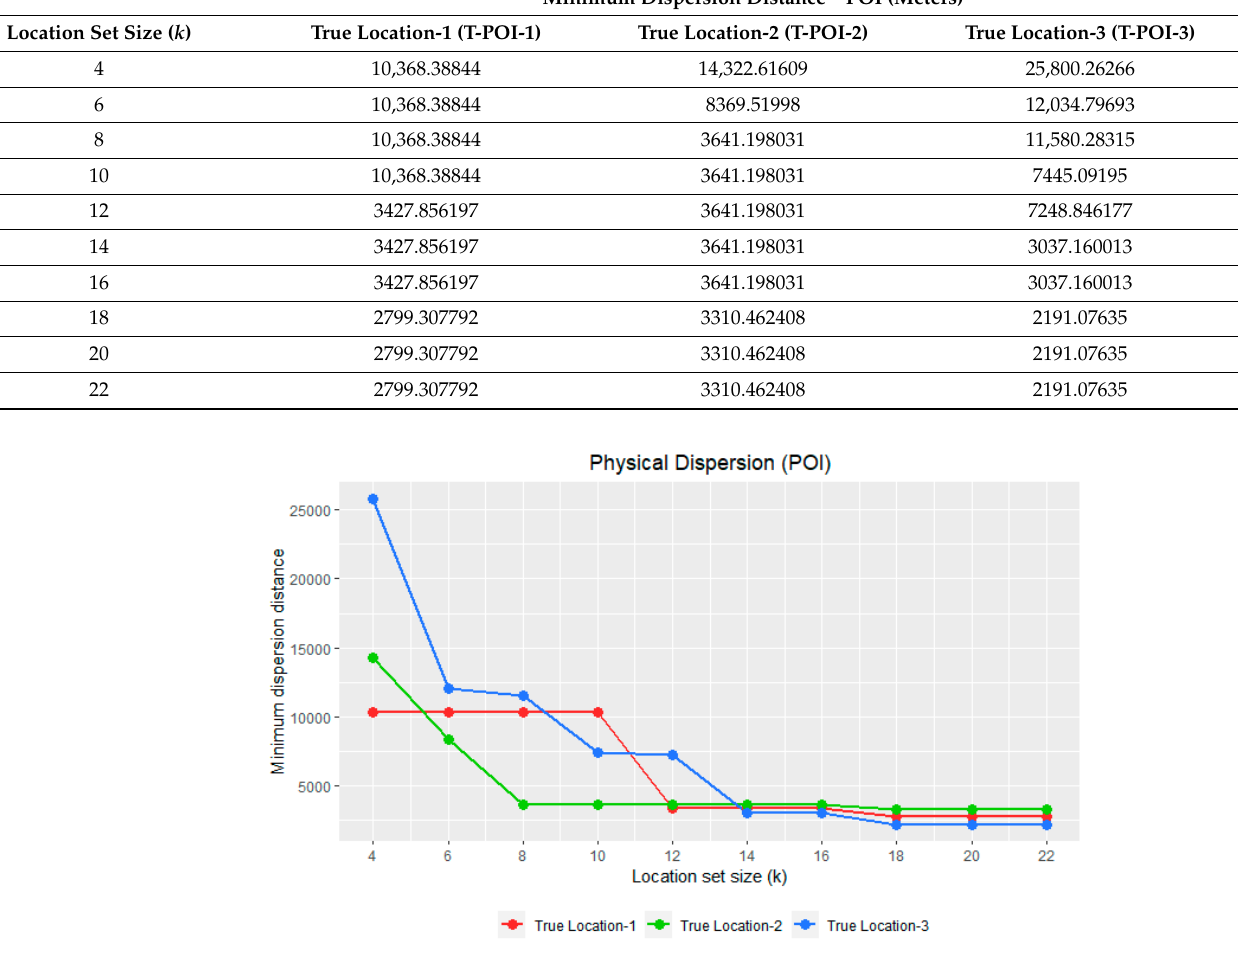
Table 4. Physical dispersion of POI locations in a location set of different sizes ( k ) for the three input